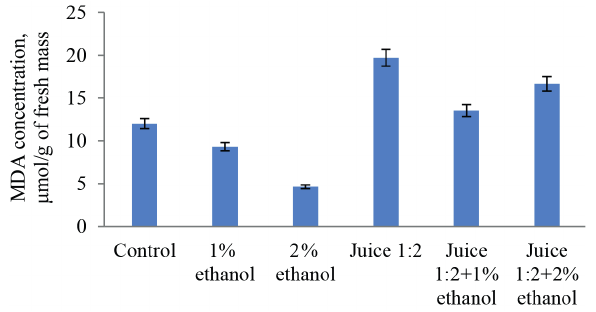
Figure 7 MDA concentration in onion roots treated with apple juice and